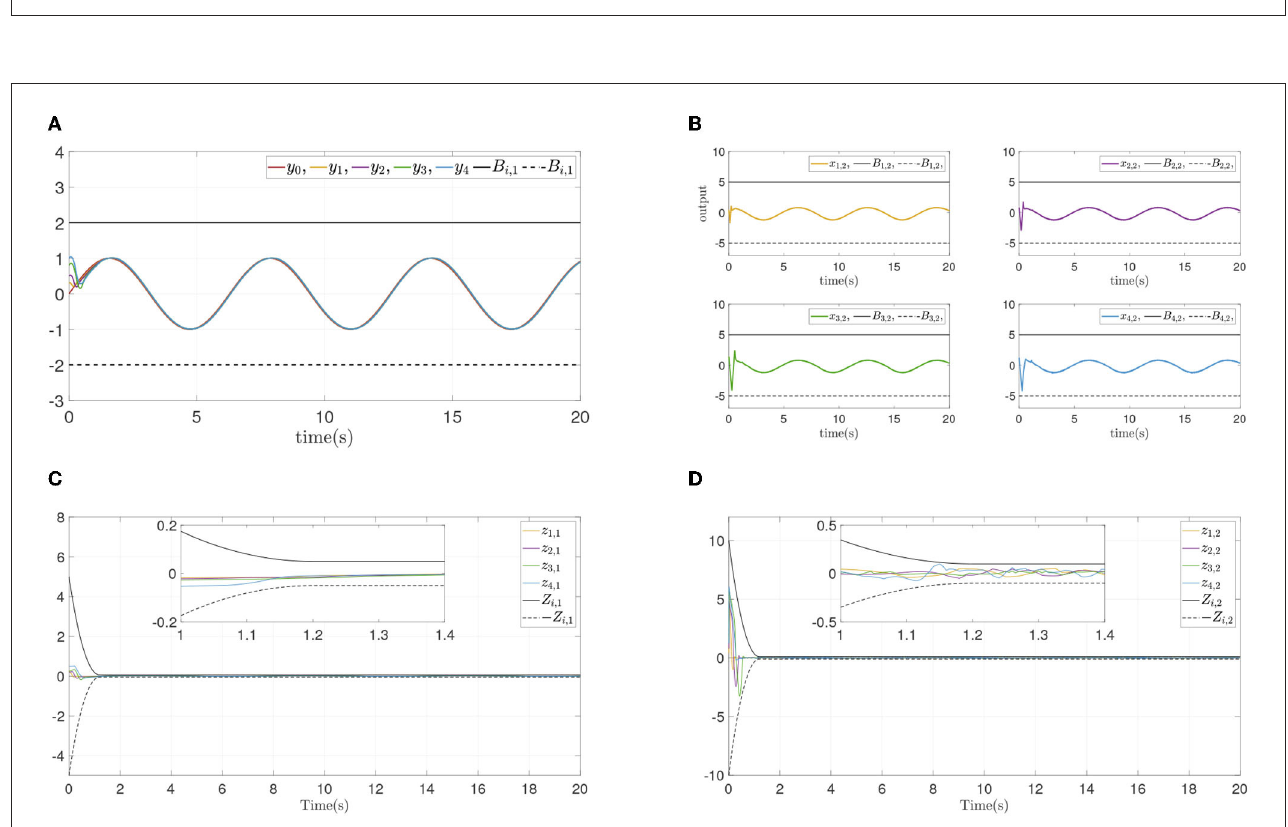
FIGURE5 Simulation results of Example A case III. (A) Followers’ outputs y i . (B) Followers’ states x i ,2 . (C) Synchronization error z i ,1 . (D) Dynamics error z i ,2